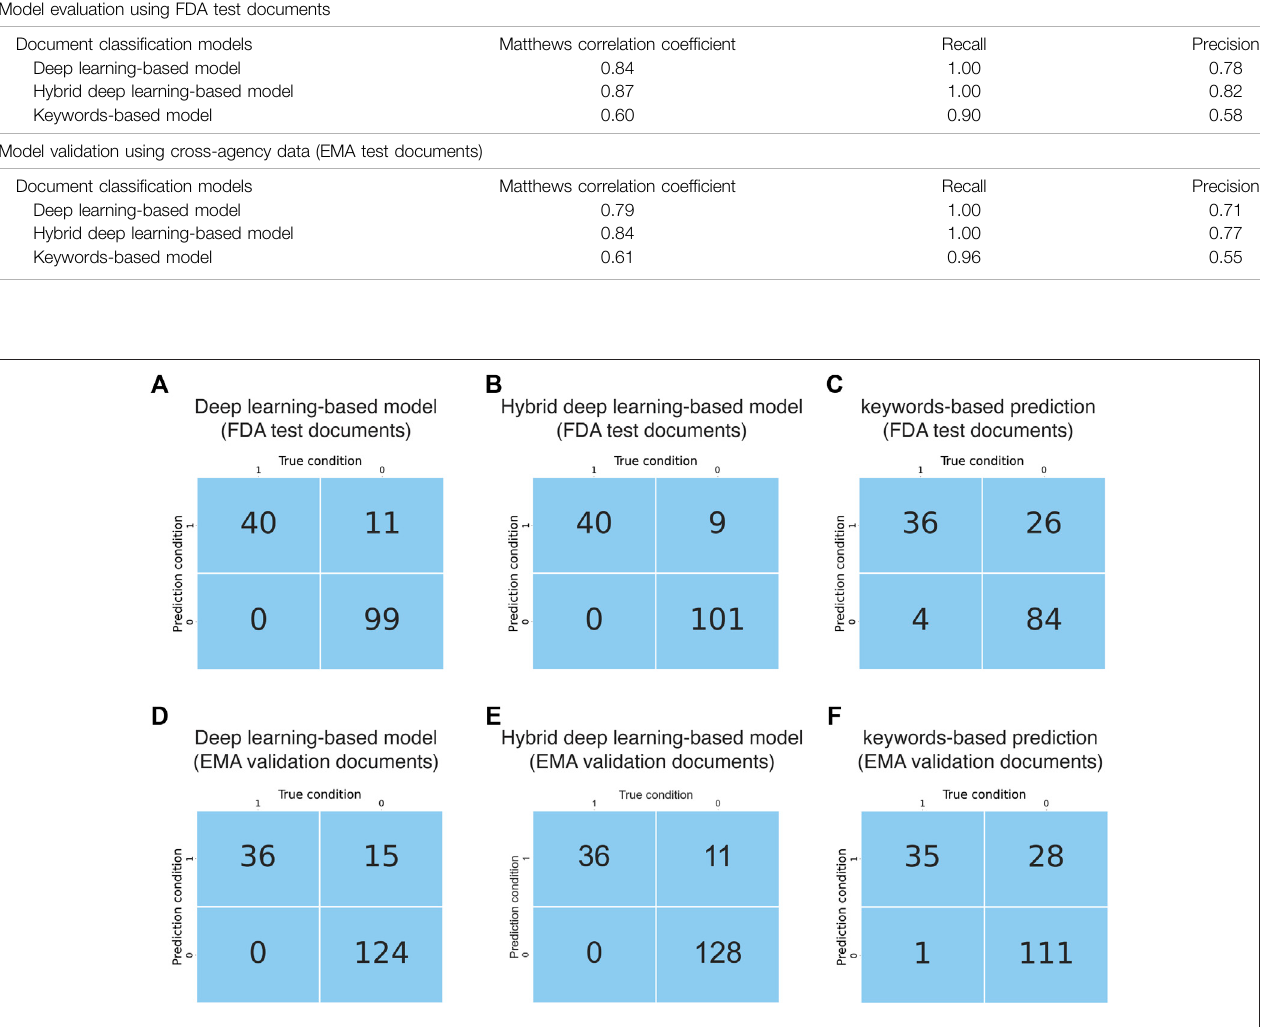
FIGURE 4 | Evaluation and validation of the document classi fi cation models. (A) Confusion matrix obtained from evaluation of the AI model using FDA test documents. (B) Confusion matrix obtained from evaluation of the hybrid deep learning-based model using FDA test documents. (C) Confusion matrix obtained